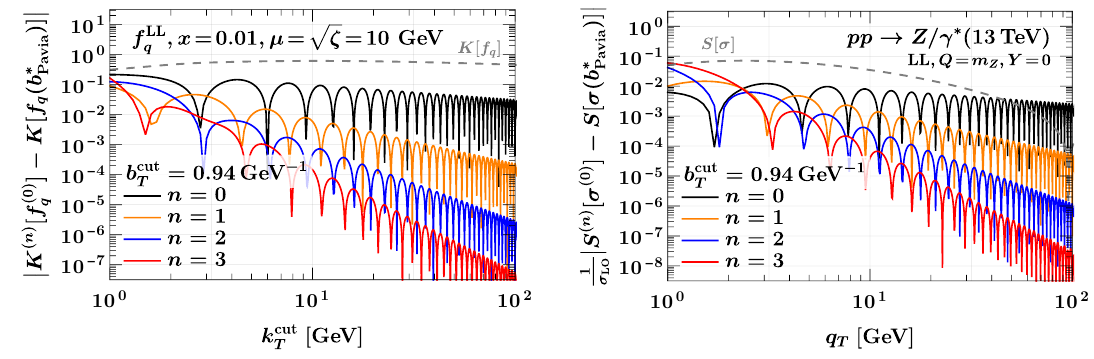
Figure 5 . Absolute error of the truncated functionals in the presence of a Landau pole for the cumulative distribution of a single TMD PDF (left) and the Z/γ ∗ transverse-momentum spectrum at the LHC